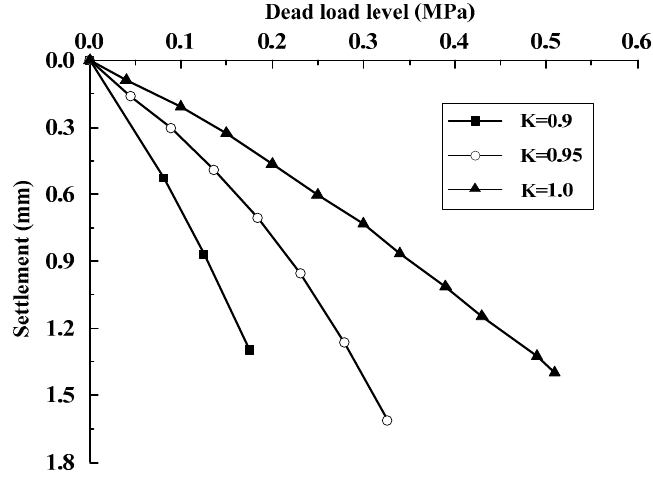
Figure 4. The relationship between settlement and dead load level in K 30 test.